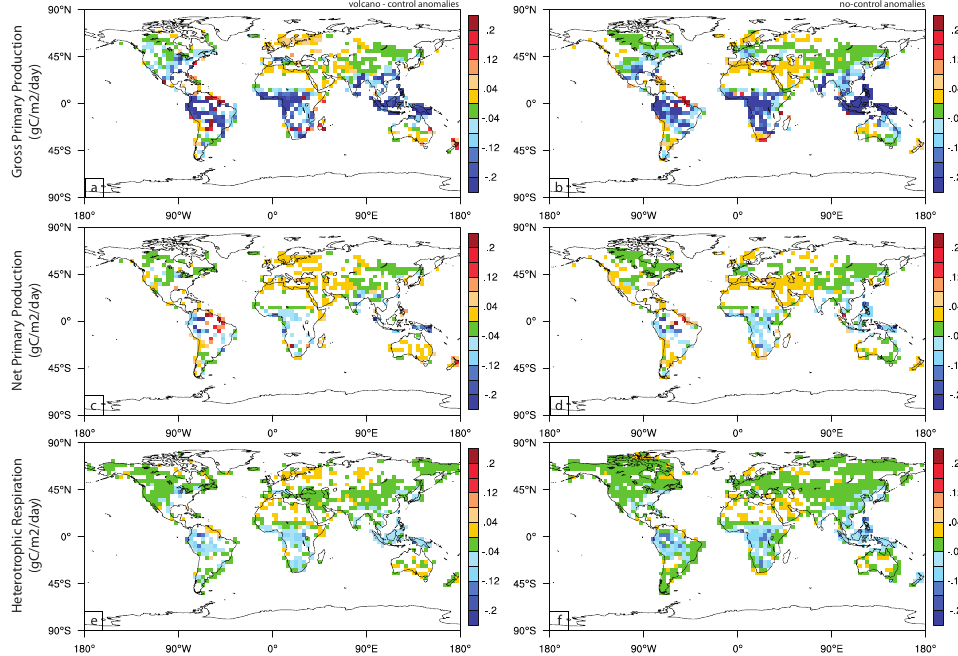
Fig. 9. Gridded average anomalies for the indicated modeled variables, averaged over the subset of 5 eruptions in Table 1 for the two-year period following each eruption. Only anomalies at the 90% significance level are shown here. All the anomalies in the left-column are computed with respect to the control run; all the anomalies in the right-column use the “no-control” method. The variable plotted in each row is on the far left – gross primary production (a–b) , net primary production (c–d) , heterotrophic respiration (e–f) , moisture stress (g–h) , net ecosystem productivity (i–j) , and surface flux of carbon (k–l) . Positive flux in (k–l) indicates uptake of carbon by